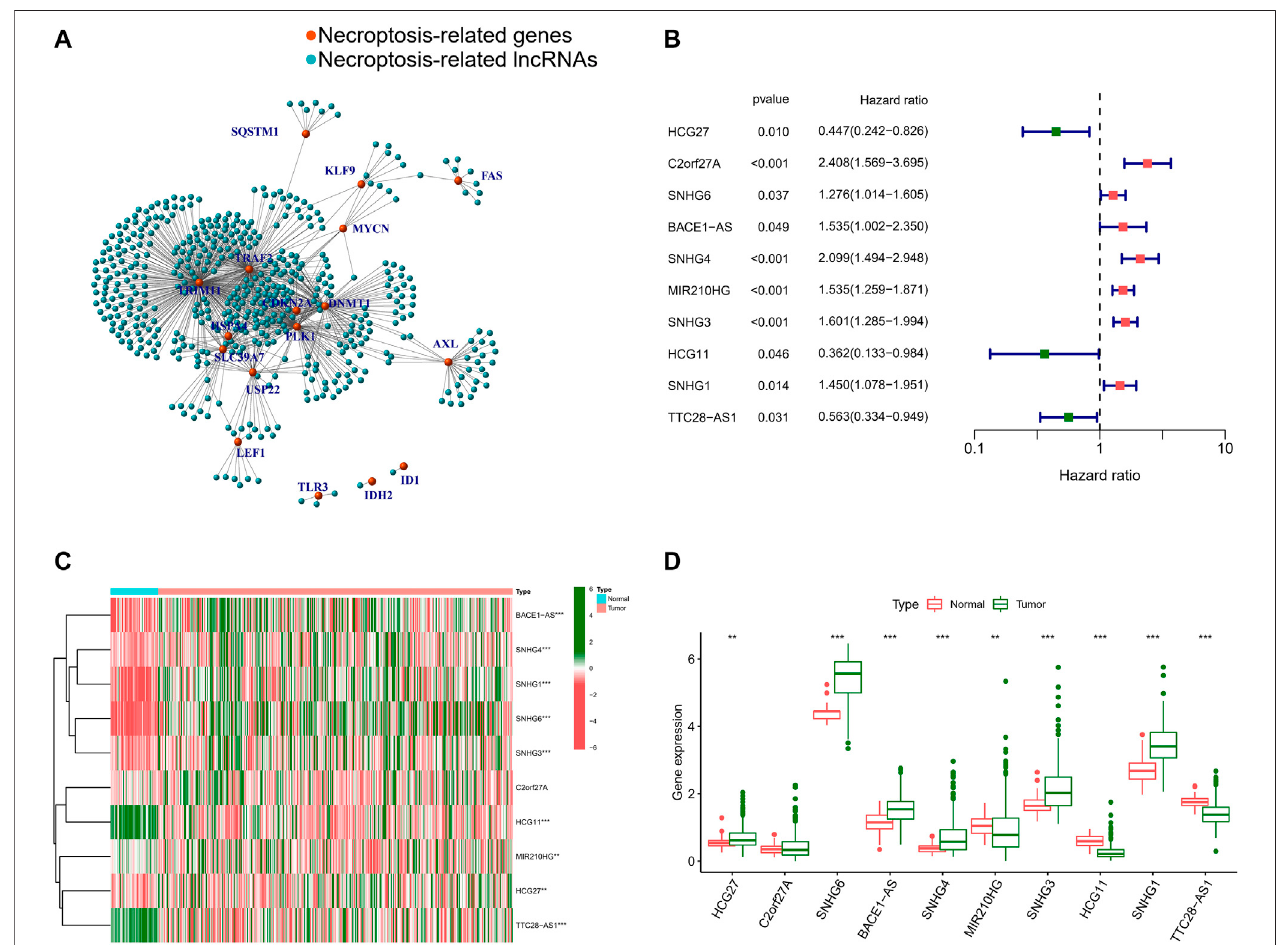
FIGURE3| Identi fi cationofNRLs. (A) ThenetworkbetweenNRGsandNRLs(correlationcoef fi cients > 0.4and p < 0.001). (B) TheprognosticNRLswereextracted byunivariateCoxregressionanalysis. (C) Heatmap ofprognosticNRLsintumourtissuesandadjacentnormaltissues. (D) Theexpression ofprognosticNRLsintumour tissues and adjacent normal tissues. (*, p < 0.05; **, p < 0.01; ***, p <